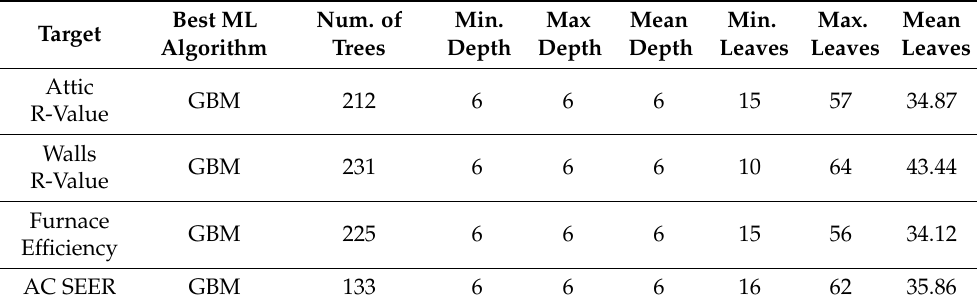
Table 10. Model hyperparameters for all targets using thermostat-derived information.